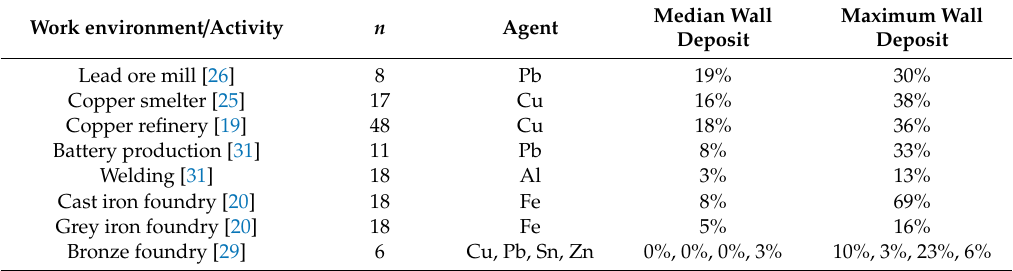
Table 2. Summary of findings of internal wall deposits as a percentage of total catch (filter plus walls) in field samples using the IOM